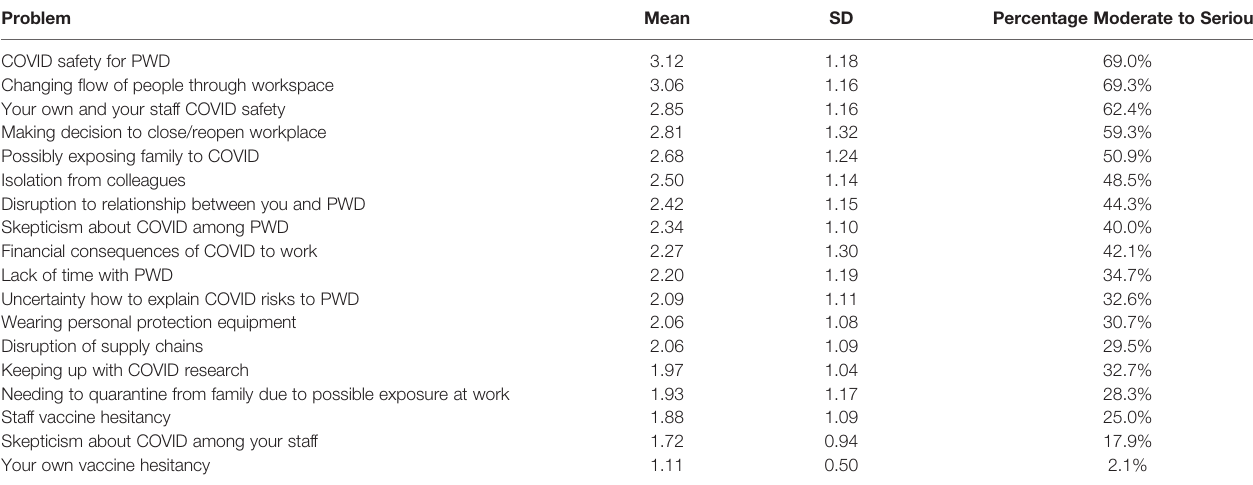
TABLE 3 | Problems in the workplace (Scale Range 1= not a problem to 5 = serious problem). Problem Mean SD